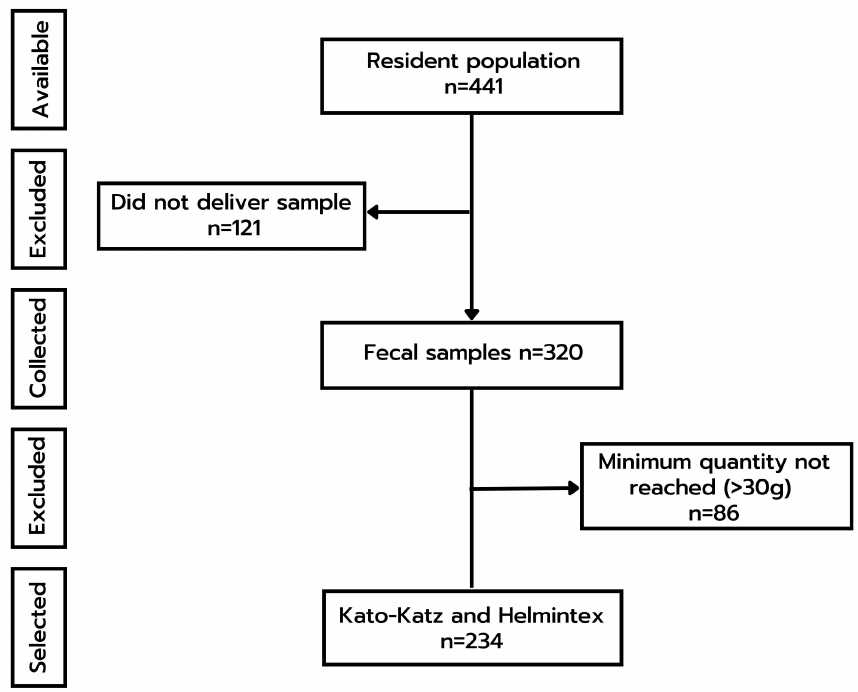
Figure 2. Flow chart showing the sample inclusion and exclusion criteria utilized in this study.